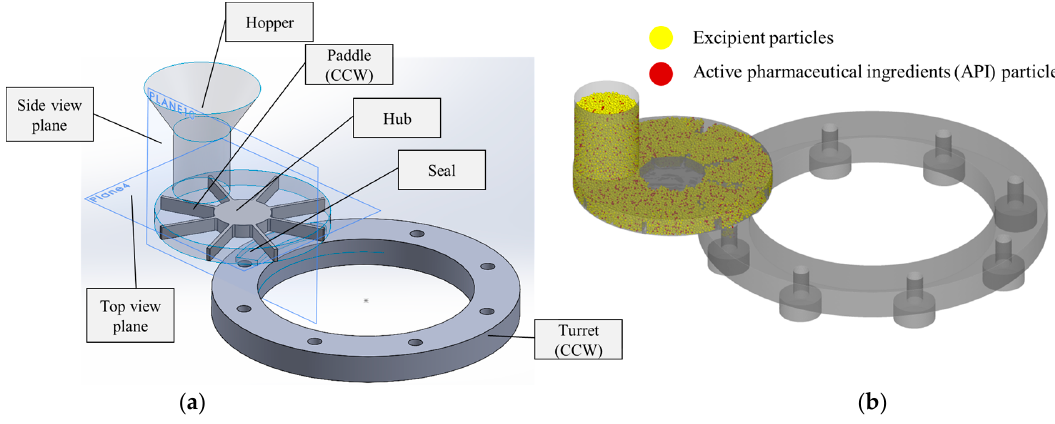
Figure 2. ( a ) Schematic of the feed frame system of the kg ‐ pharma RoTab tablet press. Both the paddle and the turret rotate in counterclockwise (CCW) direction. ( b ) A snapshot from the DEM simulation showing the filled hopper and the feed ‐ frame.